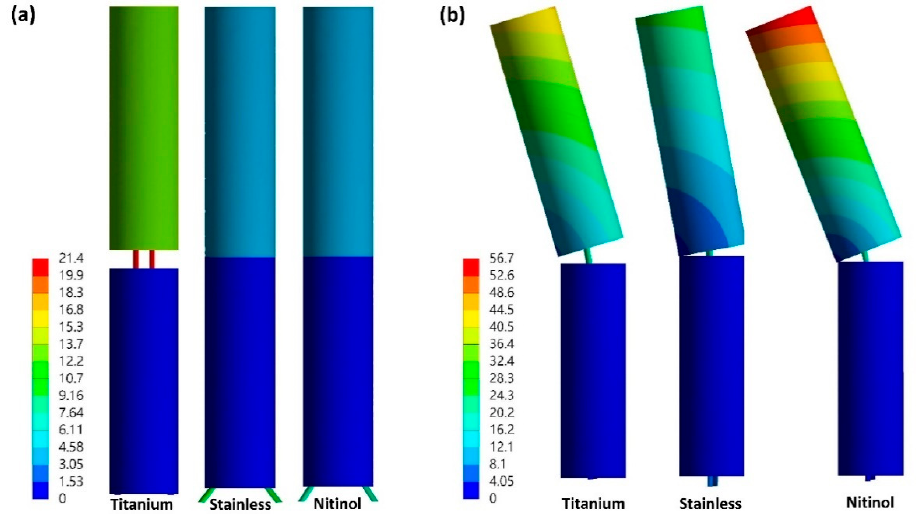
Figure 6. Total deformation (mm) of the fractured bone with nails and without end cap under compression ( a ) and bending ( b ).